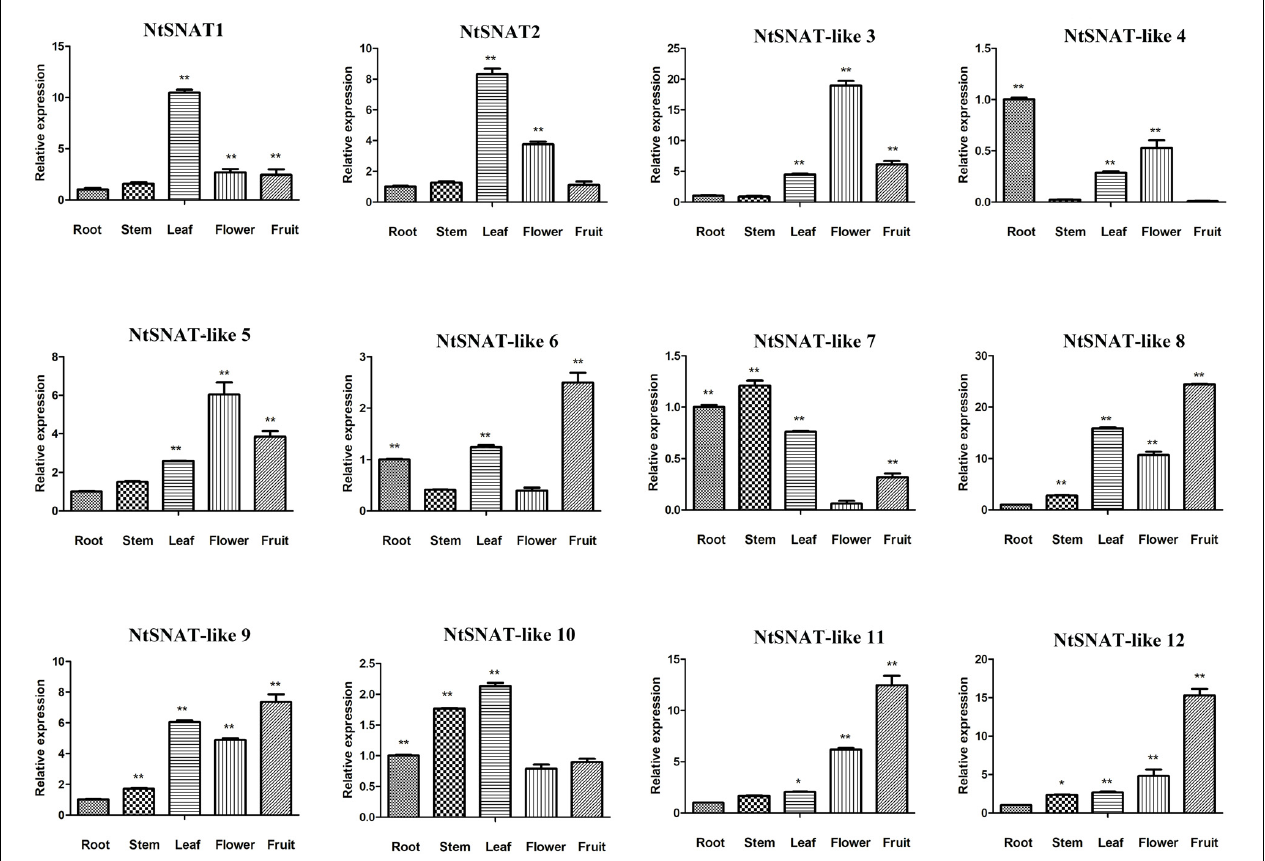
FIGURE 4 | Expression profile of NtSNAT candidates in different tobacco organs based on qRT-PCR results. Single asterisk (*) indicates significant differences at p ≤ 0.05, and double asterisks (**) indicate extremely significant differences at p ≤ 0.01.